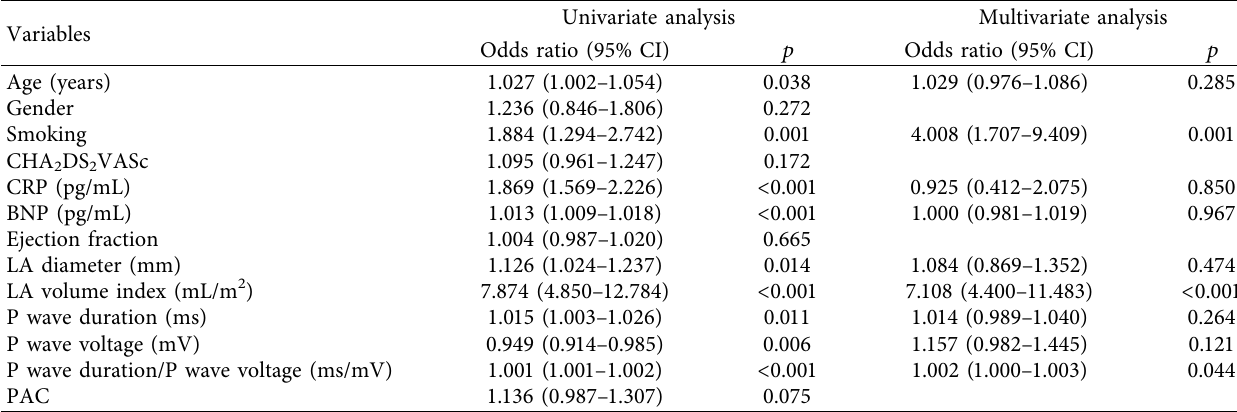
Table 7: Univariate and multivariate regression analyses of predictors of new-onset atrial